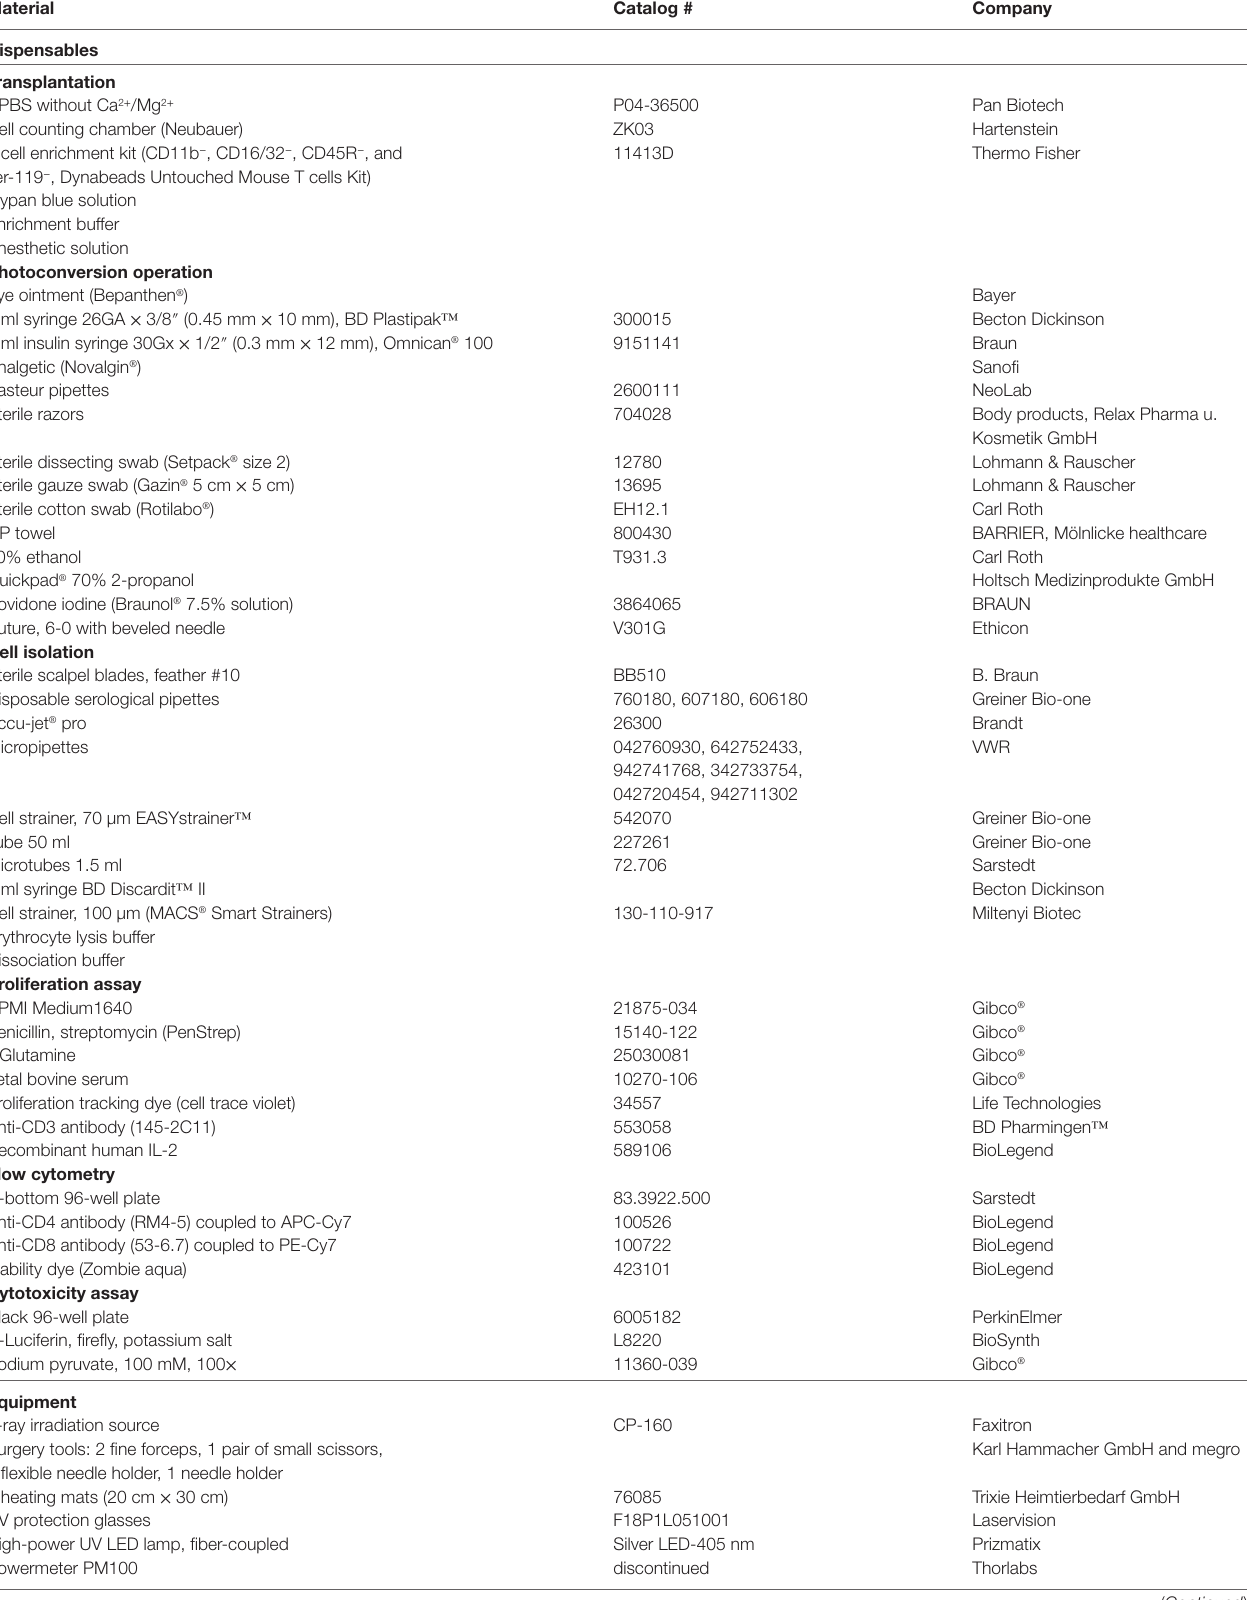
tAblE 1 | Materials used for the photoconversion and associated